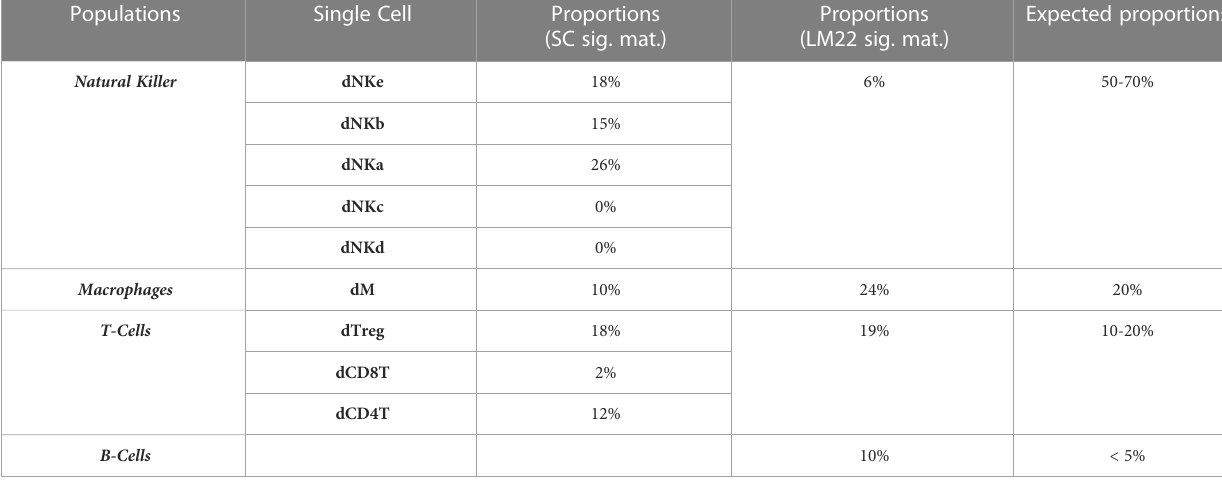
TABLE 2 List of populations considered and relative abundances in RPL.